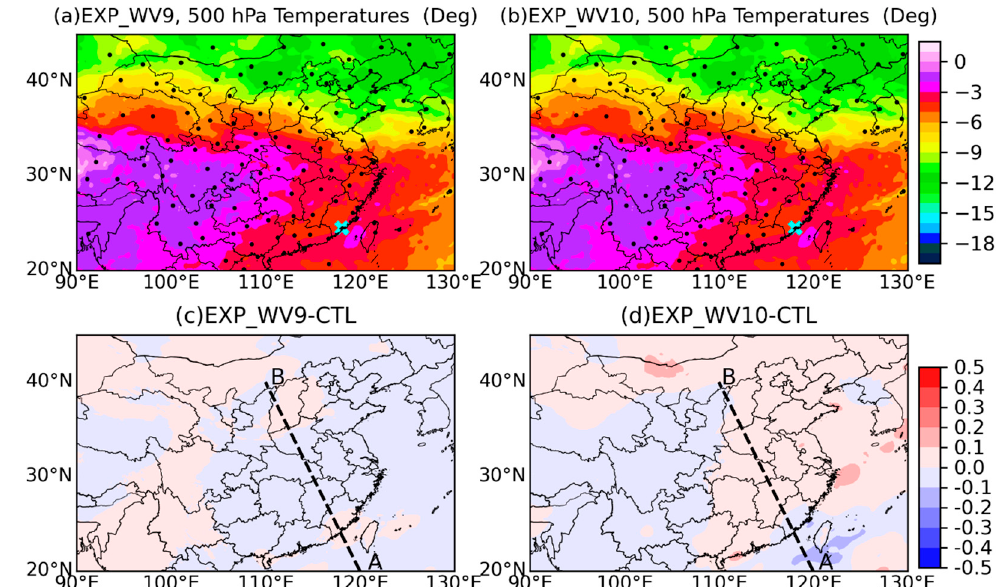
Figure 8. Spatial distributions of 500 hPa temperature field in the ( a ) EXP_WV9 and ( b ) EXP_WV10; ( c ) EXP_WV9 − CTL and ( d ) EXP_WV10 − CTL at 0000 UTC in 5 July 2020. The black markers stand for locations of radiosondes. The locations of A and B are (120°E, 20°N) and (110°E, 40°N), respectively. The location of the cyan cross is (118.1°E, 24.5°N).